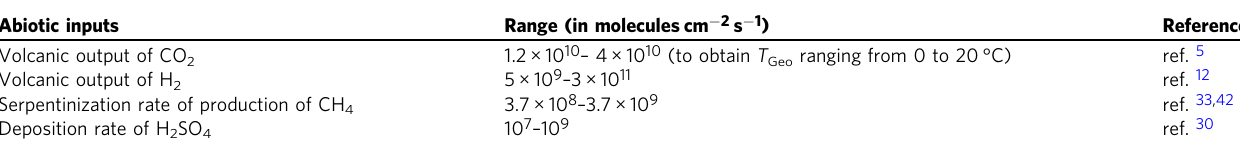
Table 1 Abiotic inputs of CO 2 , H 2 , CH 4 and H 2 SO 4